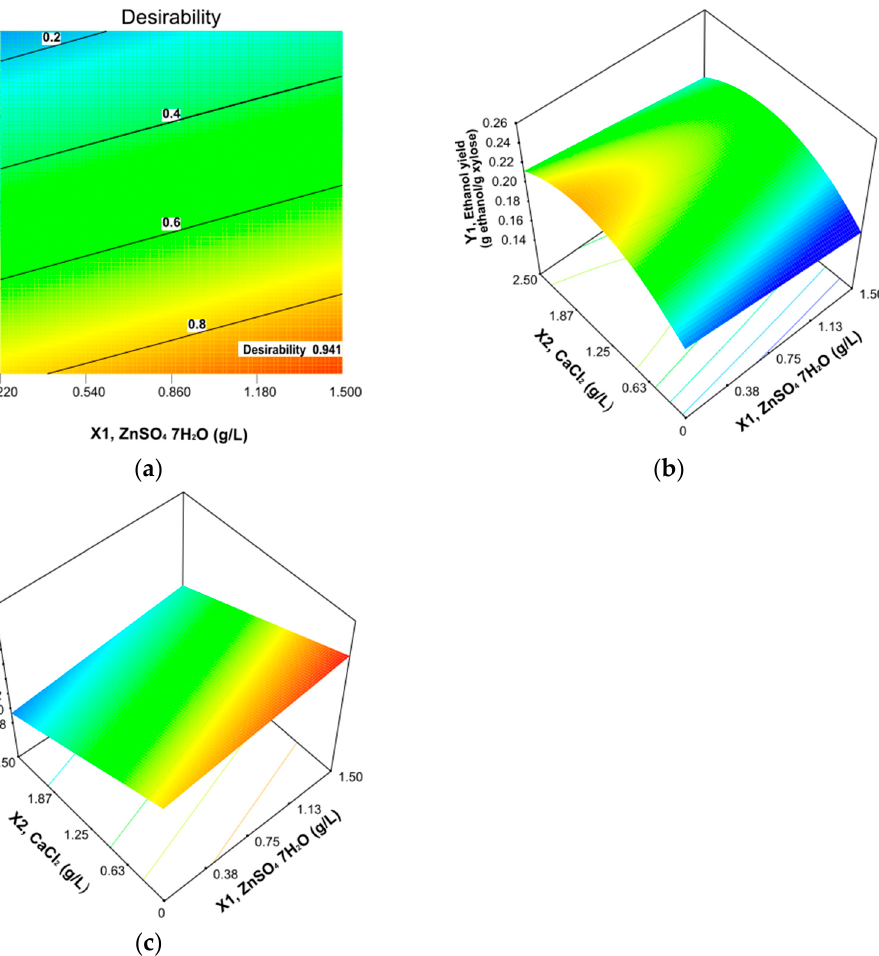
Figure 2. ( a ) Desirability plot showing the best combination of ZnSO 4 ·7H 2 O and CaCl 2 for an optimal ethanol yield. ( b ) Response surface plots showing the effect of zinc and calcium on ethanol yield. ( c ) Response surface plots showing the effect of zinc and calcium on xylitol yield. Table 2. Comparison of model prediction and experimental values after the optimization.